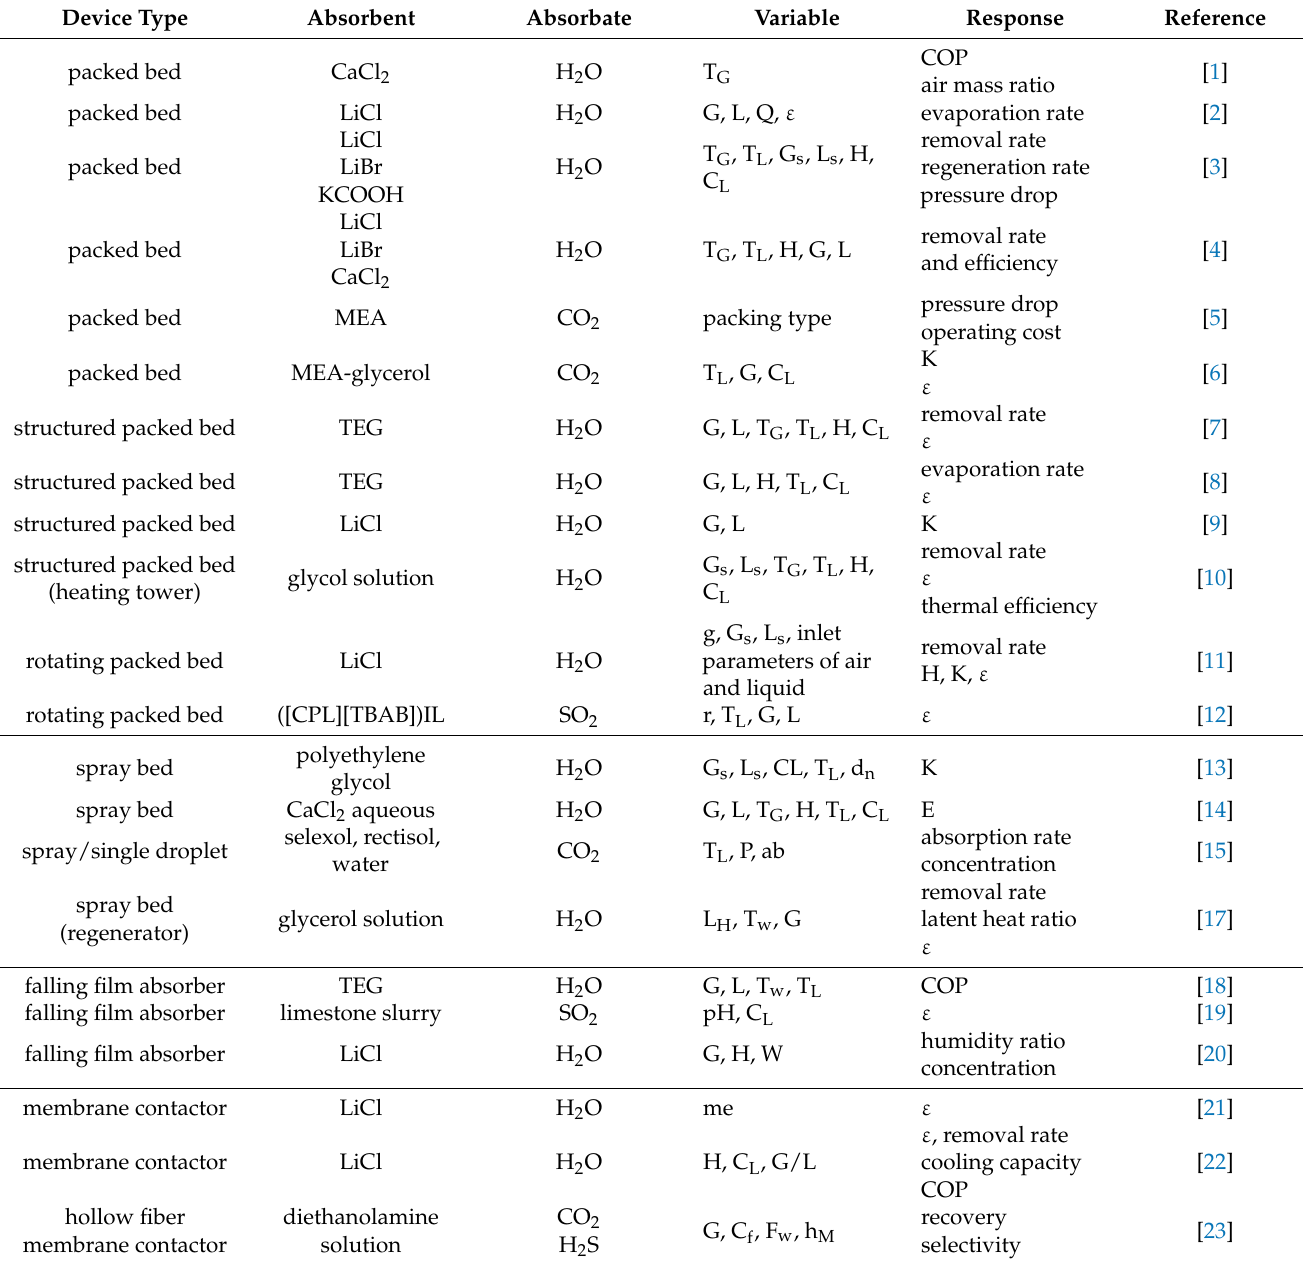
Table 1. The searched studies associated with the absorption performance affected by operating variables similar to this